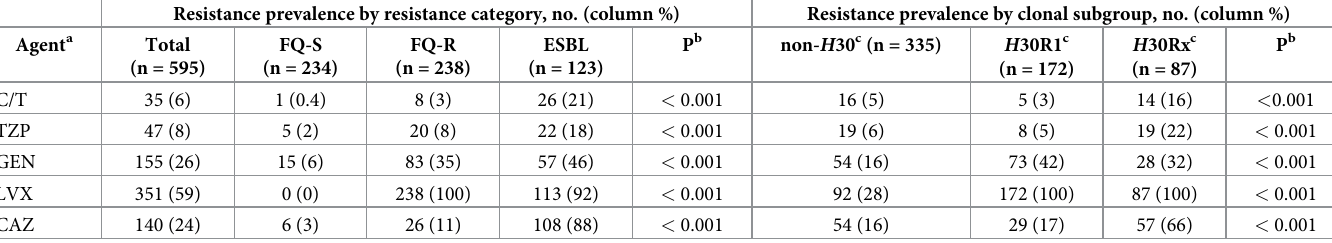
Table 1. Prevalence of resistance to ceftolozane/tazobactam and comparator agents in relation to resistance category and H 30 subclone status among 595 E . coli clinical isolates from veterans. Resistance prevalence by resistance category, no. (column %) Resistance prevalence by clonal subgroup, no. (column %)